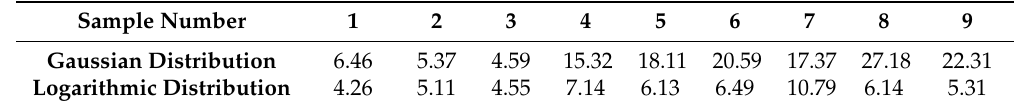
Table 4. The pseudo failure characteristics (PFCs) of each sample.